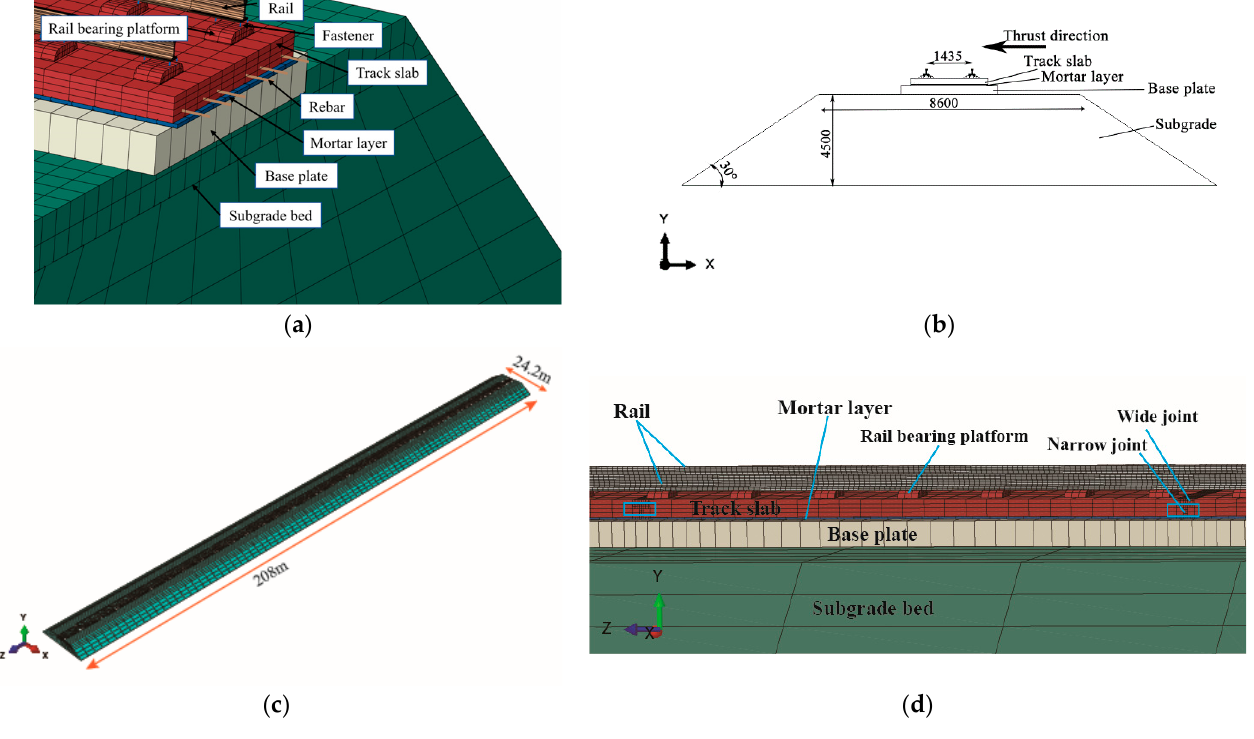
Figure 2. CRTS II slab ballastless track model on subgrade. ( a ) composition of each part of the model, ( b ) model cross section size, ( c ) overview of numerical model, ( d ) model partial enlargement of lateral view. Table 1. Structural dimensions and material properties of track system.